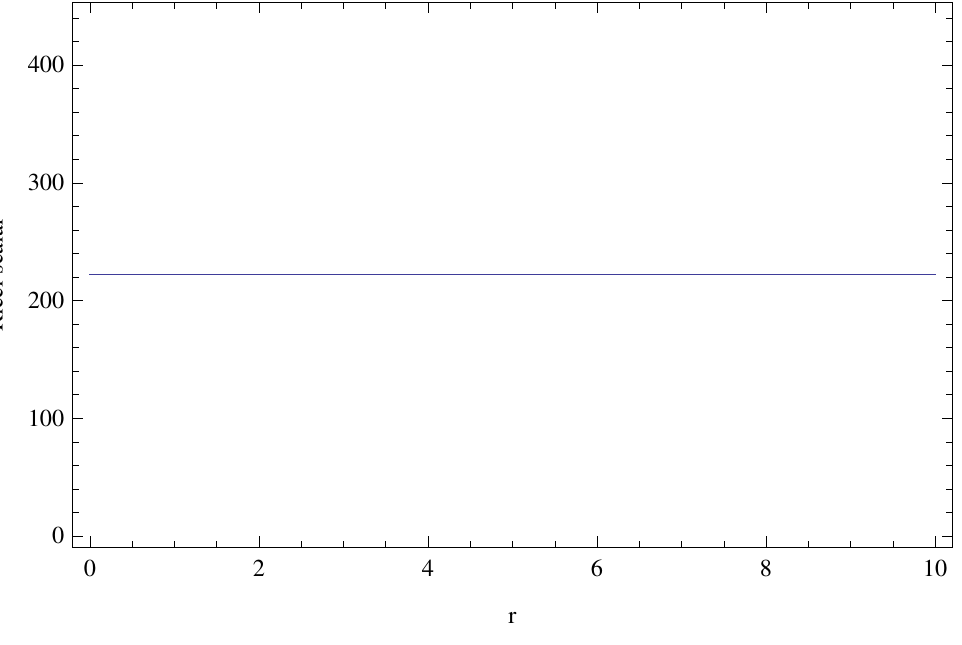
Figure 7. The Ricci scalar is plotted against the radial parameter r , for dark energy matter ( ω = − 1), for the values of constants λ = 0.1, C 1 = 0.01, C 2 = 0.5, C 3 =